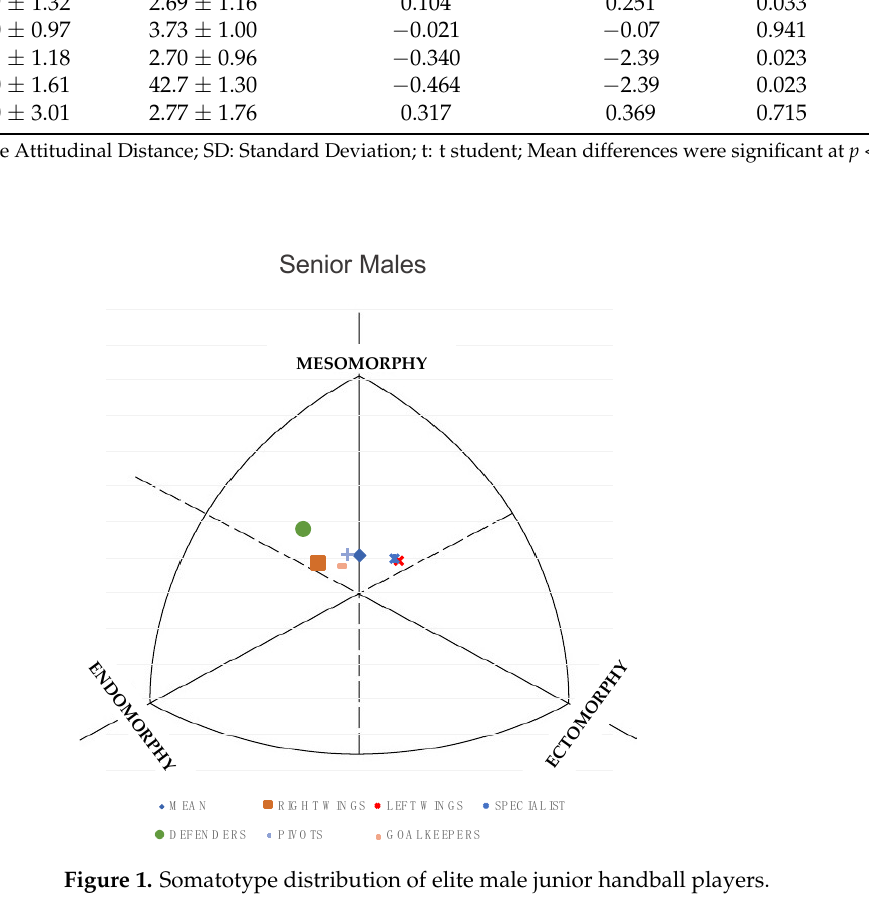
Figure 2. Somatotype distribution of elite male senior beach handball players. Table 5 There are significant differences in some skinfolds such as triceps ( p < 0.01), biceps ( p < 0.05), front thigh ( p < 0.05) and medial calf ( p < 0.01), as well as in the sum of 6 skinfolds ( p < 0.05). There was a general tendency for senior players to have lower skinfold values. Overall effect sizes were moderate to large. Table 5. Descriptive data on skinfolds, circumferences, diameters, and the differences between junior and senior are pre- sented in Table 4.